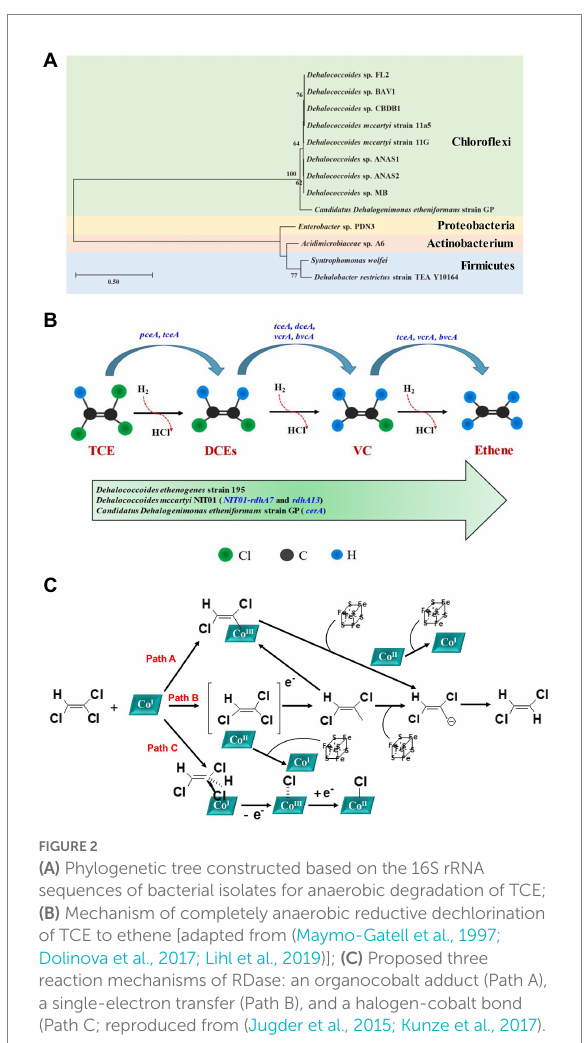
FIGURE 2 (A) Phylogenetic tree constructed based on the 16S rRNA sequences of bacterial isolates for anaerobic degradation of TCE; (B) Mechanism of completely anaerobic reductive dechlorination of TCE to ethene [adapted from (Maymo-Gatell et al., 1997; Dolinova et al., 2017; Lihl et al., 2019)]; (C) Proposed three reaction mechanisms of RDase: an organocobalt adduct (Path A), a single-electron transfer (Path B), and a halogen-cobalt bond (Path C; reproduced from (Jugder et al., 2015; Kunze et al.,